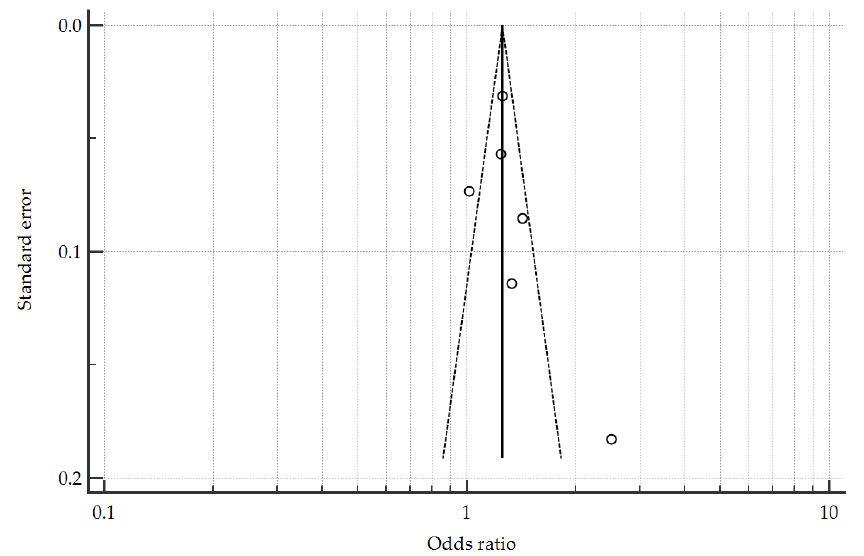
Figure 5. Funnel plot (with pseudo 95% confidence intervals) to assess publication bias; Egger test for publication bias = 2.047, 95% CI: 0.955 to 3.14, p = 0.0065.